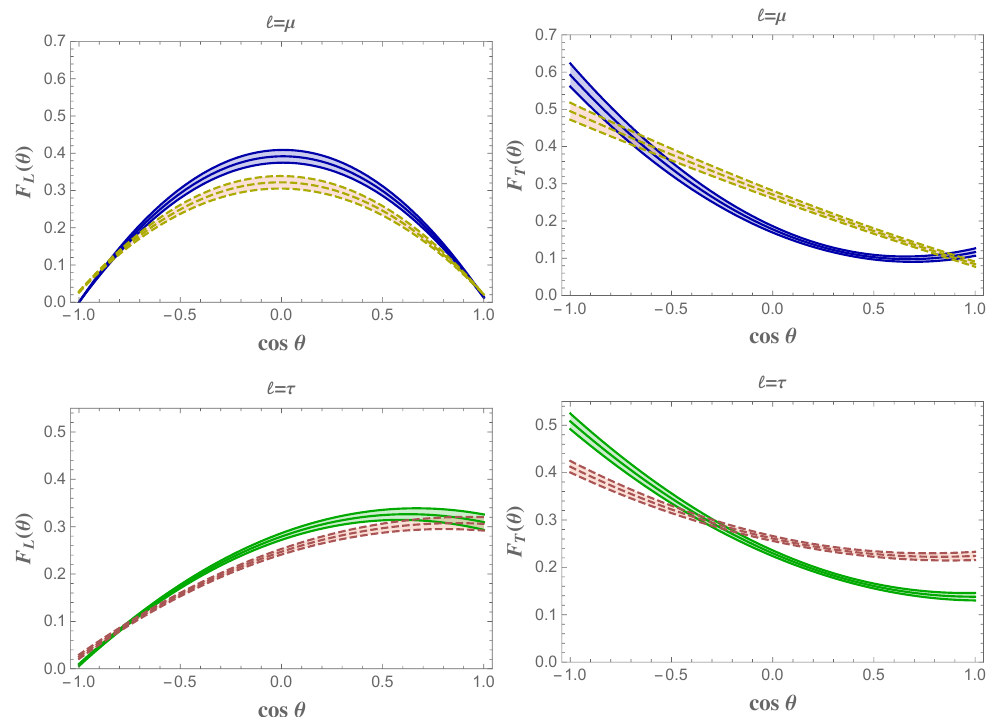
Figure 16 . Distributions F L ( (cid:18) ) (left) and F T ( (cid:18) ) (right). Upper and lower plots refer to ‘ = (cid:22) and ‘ = (cid:28) , respectively. Color codes as in (cid:12)gure 14.